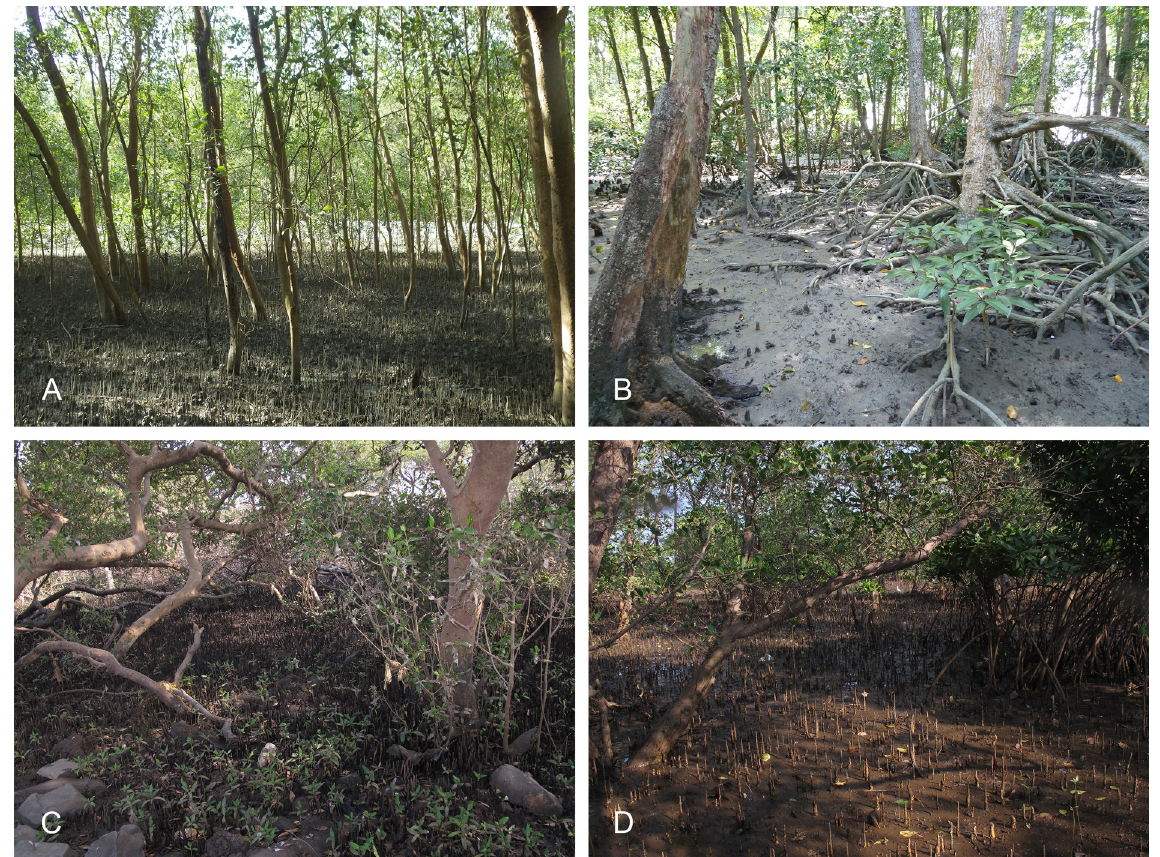
Fig. 44. Paromoionchis penangensis gen. et sp. nov., habitats. A . Malaysia, Penang, open Avicennia mangrove with different types of mud (station 261, type locality). B . Western Peninsular Malaysia, Rhizophora and Sonneratia mangrove with soft mud, next to a landfill (station 17). C . India, Maha- rashtra, Avicennia mangrove with soft mud and a wall of large rocks (station 45). D . India, Maharashtra, Avicennia mangrove with a few small Rhizophora , soft mud and pools (station